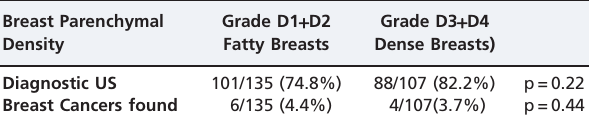
Table 2 - Diagnostic performance of US and the identification of breast cancers based on breast parenchymal density.